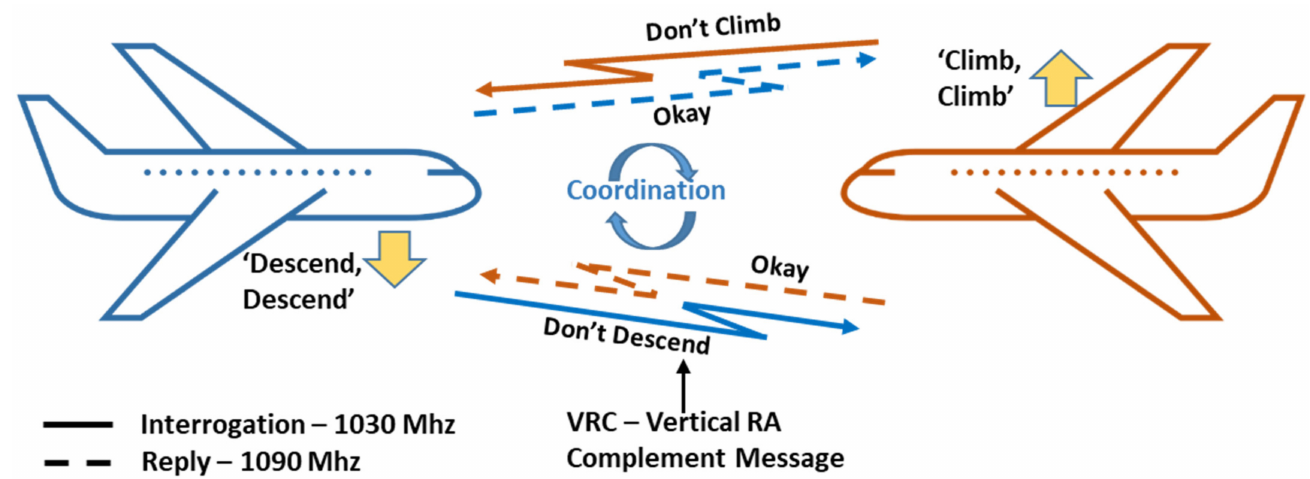
Figure 2. TCAS-II collision avoidance maneuver